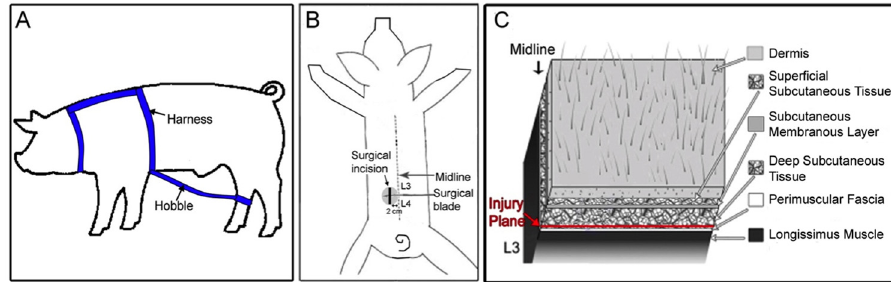
Fig 1. Movement restriction and fascia injury methods. (A) Hobble device used to induce movement restriction. (B) Location of fascia injury. (C) Location of fascia injury